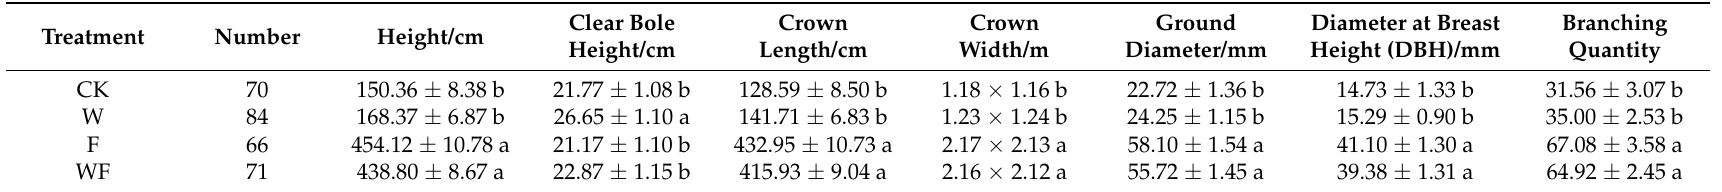
Table 2. On 18 November 2017, all the Eucalyptus trees were investigated and the following growths were